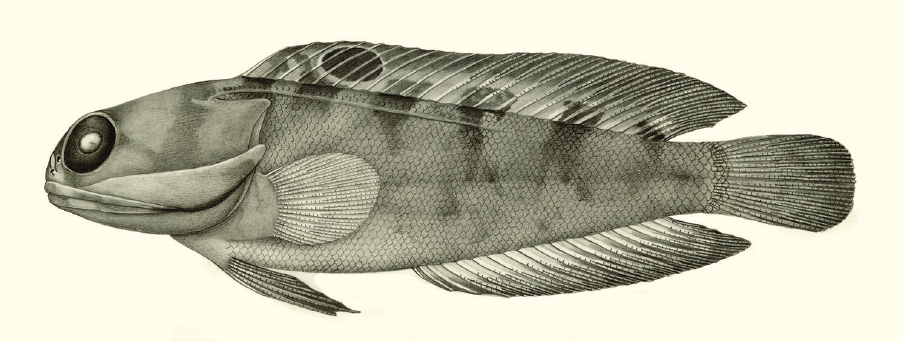
Figure 13. Opistognathus brasiliensis , ANSP 141861, 122.5 mm SL, male, southeastern Brazil. Drawn by Jack R. Schroeder; after Smith-Vaniz